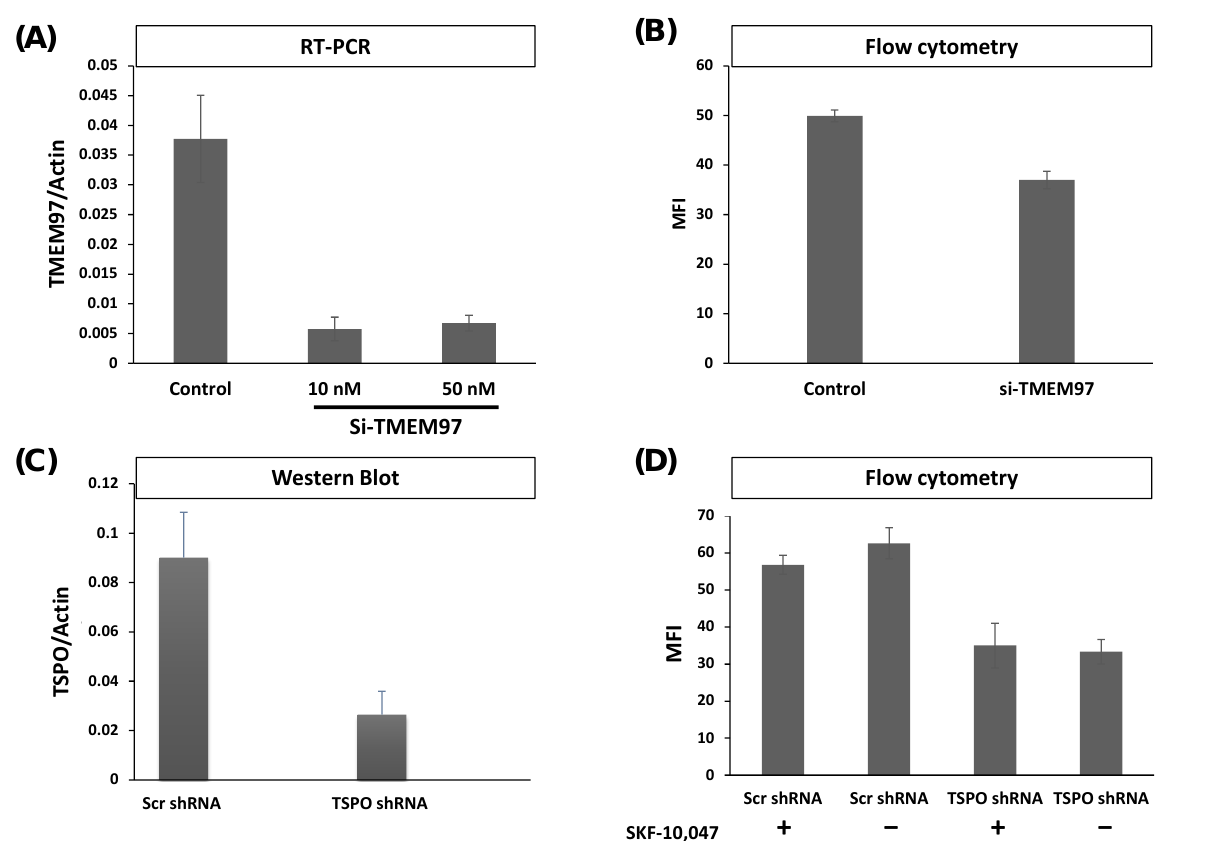
Figure 1. TMEM97 and TSPO attenuation both reduce S2R ligand-binding by SW120. ( A ) Gene expression by RT-PCR showing the attenuation of TMEM97 mRNA in MP cell lines. The knockdown of TMEM97 by siRNA (either 10 or 50 nM per treatment) was confirmed by more than 80% ( t -test p < 0.001). ( B ) Flow cytometry assessment of SW120 binding to MP cells ( n = 6). Median fluorescence intensity (MFI) was determined by measuring the FITC signal (FL1). Kaluza software was used to analyze the data. Attenuation of TMEM97 (10 nM siRNA) resulted in significant SW120 reduction ( t -test p < 0.0001). ( C ) Detection of TSPO expression levels by Western blot after TSPO shRNA knockdown compared with scramble shRNA control. The image of the Western blot is supplied in Figure S1E. Six independent clones were generated after transduction with viral particles, with all showing visible attenuation normalized to actin. A significant reduction of approximately 70% was achieved ( t -test p < 0.00001). ( D ) The chart shows a flow cytometry evaluation of SW120 binding after TSPO knockdown by shRNA. MP cells were incubated with SKF-10,047 or DMSO as a negative control. All cells were incubated with 30 nM of SW120 in complete media for 30 min at 37 ◦ C. Treatment with SKF-10.047 had no significant impact on SW120 binding (Two-way ANOVA). In contrast, attenuation of TSPO resulted in a significant reduction in the SW120 signal (Two-way ANOVA p < 0.0001) in both conditions. Six replicates of each cell line were